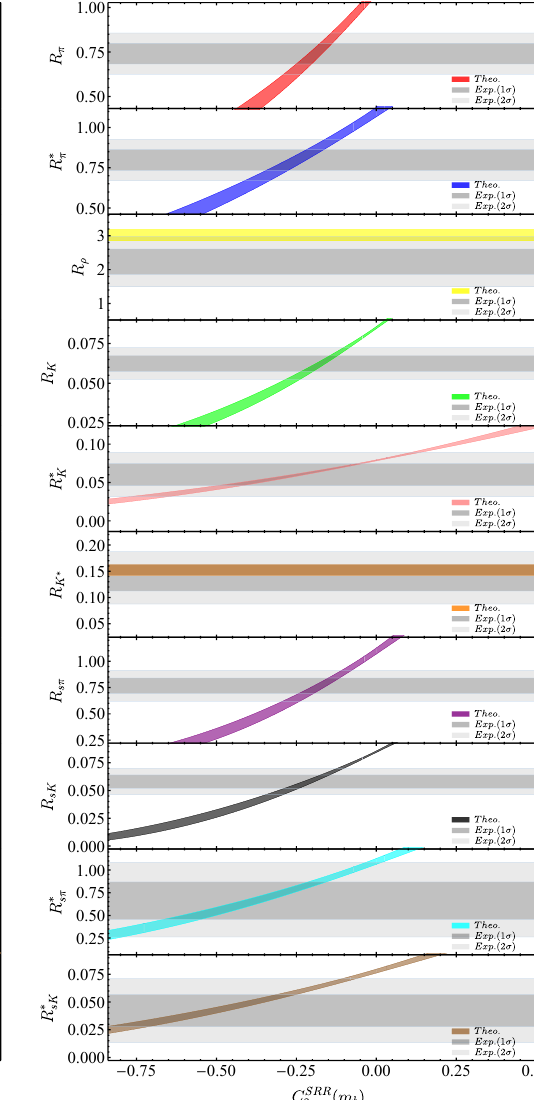
( m b ) (left) and C SRR